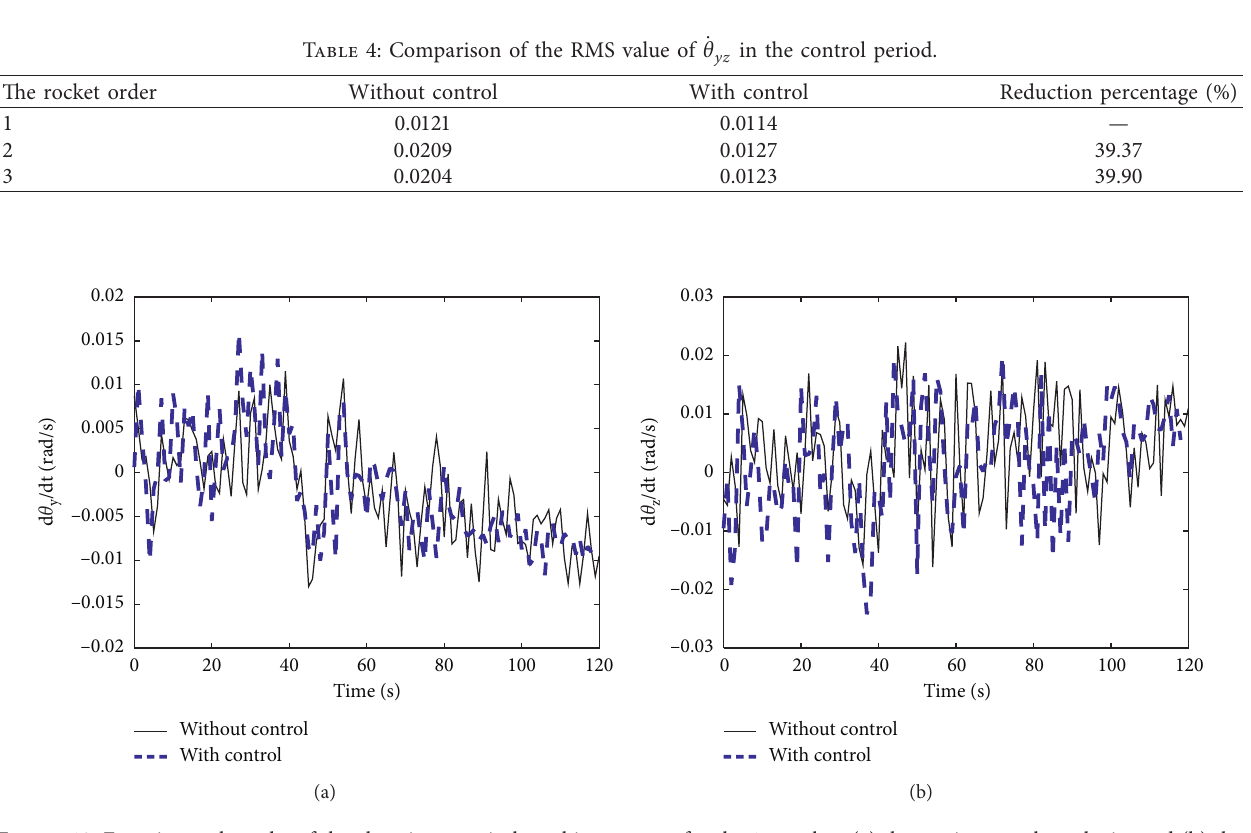
yz in the control period.